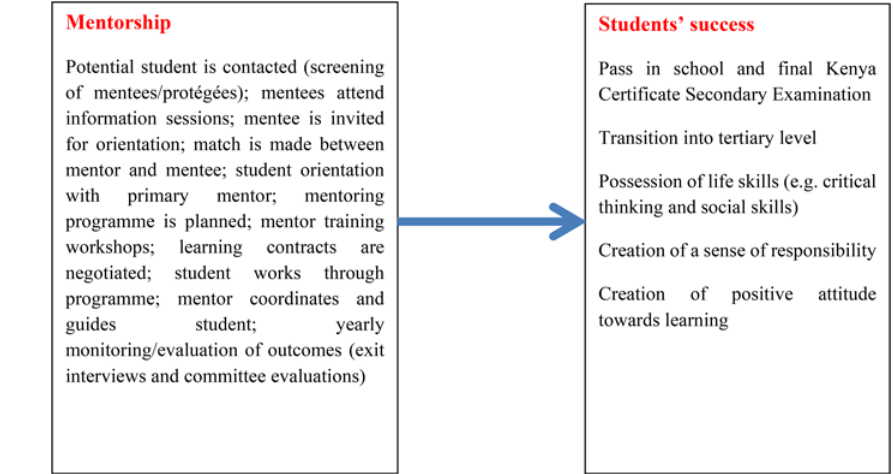
Figure 1 Framework for the Macheo Mentoring